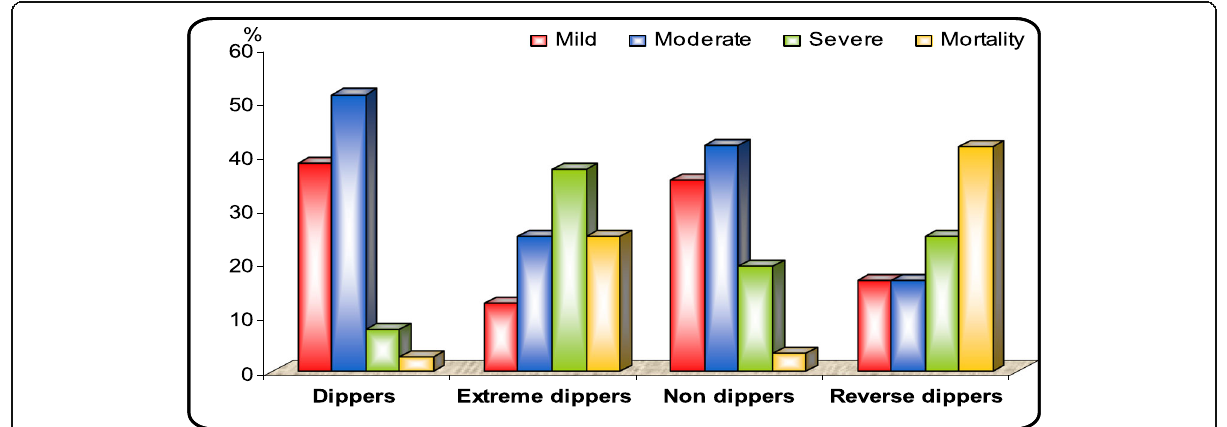
Fig. 4 Follow-up clinical severity according to blood pressure changes after 3